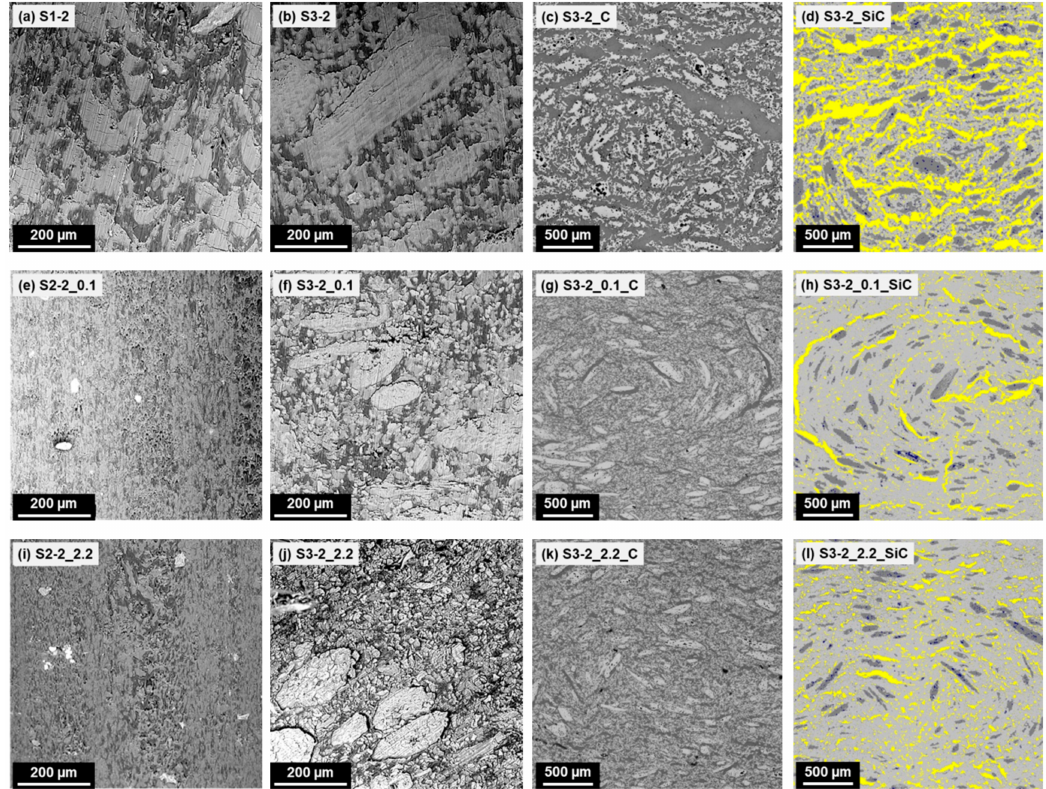
Figure 9. Comparison of green bodies without fibres (left; SEM), green bodies with fibres (second from left; SEM), porous carbon specimens (third from left; LOM), and silicon carbide specimens (right; LOM, false-colour display). Left column : bright areas—novolac; dark areas—LDPE. 2nd column : brightest areas—wood particles (large particles, approximately 200–500 µ m in length) and cellulose fibres (small, roughly circular to elliptical shapes, approximately 15 µ m in diameter); light grey areas (slightly darker than fillers)—novolac; dark areas—LDPE. Mowital and Naftosafe cannot be distinctly identified in the SEM images. 3rd column : bright areas—carbon; dark areas—pores and / or voids. Right column : light grey areas—silicon carbide; yellow areas—silicon; dark grey areas—carbon; dark blue